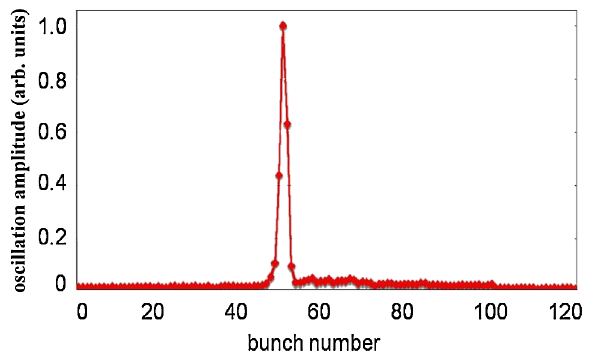
kicker pulse centered on bunch